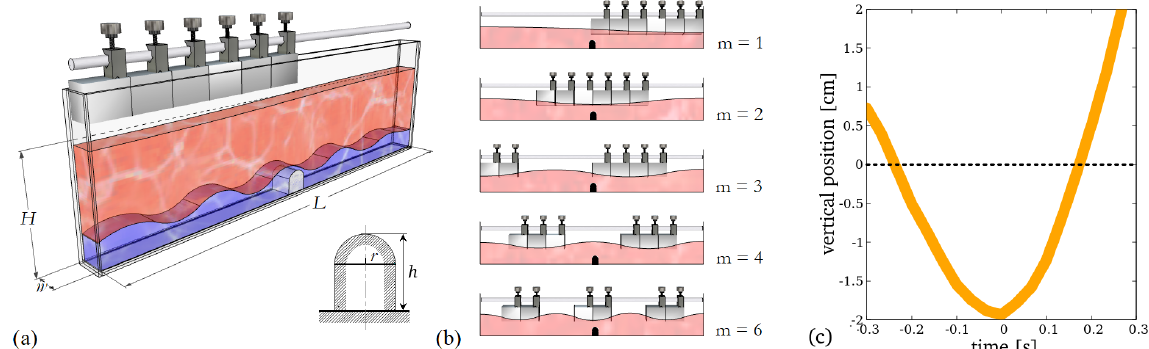
Figure 1. (a) The schematics of the setup. The geometrical parameters of the tank are L = 80cm, w = 5cm, and H 2 = h = 4cm. The shape of the obstacle is sketched in the bottom right corner ( h = 4cm, r = 1 . 75cm). (b) The configurations of the six rubber foam bumpers of the wave maker for the excitation of the various surface seiche modes and the sketch of the corresponding waveform. (c) The vertical motion of the bottom of the rubber foam bumpers at the initiation. The position is given with respect to the unperturbed water surface. The width of the line represents the error of reproducibility. Table 1. List of parameters and